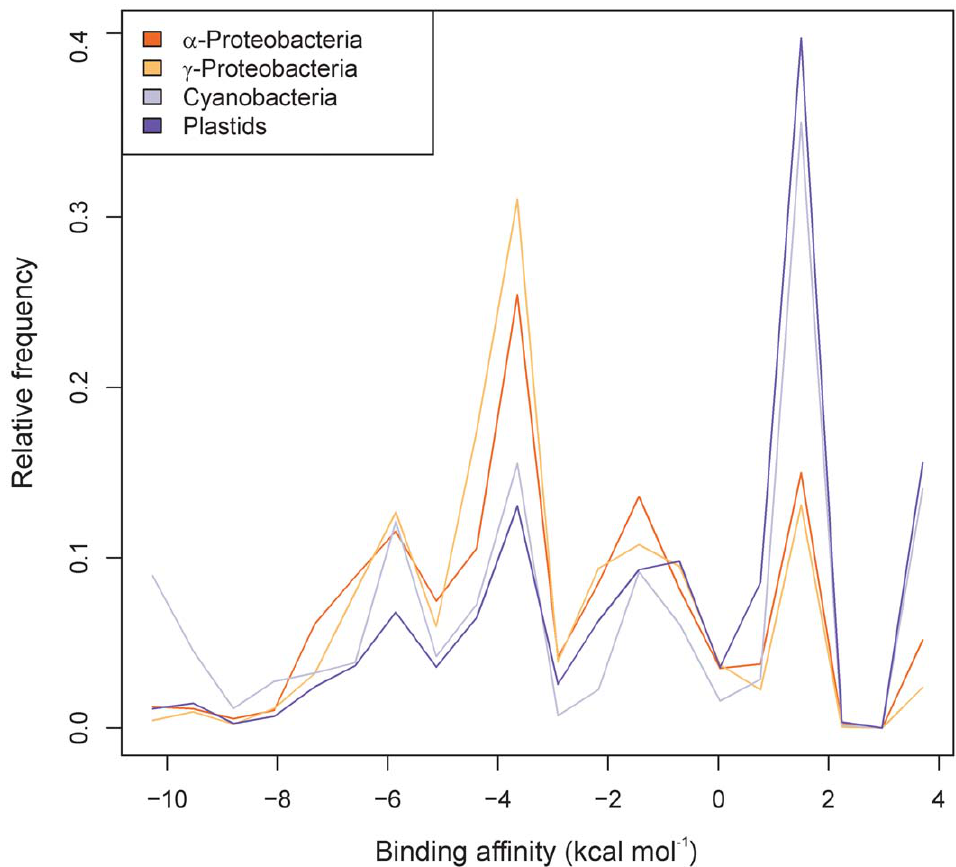
Figure 1. Genome-wide assessment of the binding affinities of the anti–Shine-Dalgarno sequence in the 16S rRNA to the 5 9 UTRs of prokaryotic genes. The 5 9 UTR sequences from -22 to -2 were used for the computations. Shown are the normalized distributions of hybridization energies of a -proteobacterial, c -proteobacterical, cyanobacterial and plastid genes. Four major peaks are clearly distinguishable in all taxonomic groups at the positions -5.9, -3.6, -1.4 and + 1.5 kcal mol 2 1 . The peaks (from left to right) correspond to: (i) mRNAs with the SD sequence AGGAG, (ii) mRNAs with the SD sequence GAGG, AGGA or GGAG, (iii) mRNAs with short SD-like sequences (AGG, GAG or GGA), which may engage in SD-type interactions with the 3 9 end of the 16S rRNA and (iv) mRNAs without SD